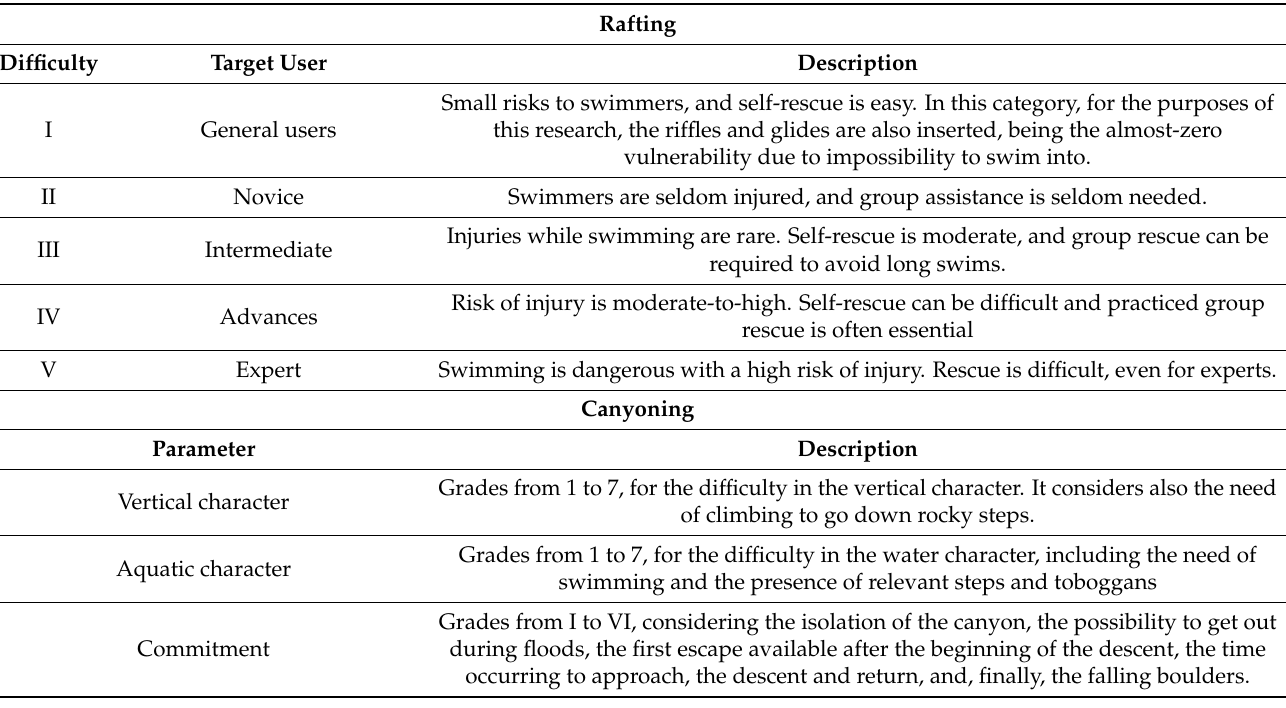
Table 4. Classification of rafting features (i.e., rapids, riffles, and glides) and canyoning reaches, according to the difficulty